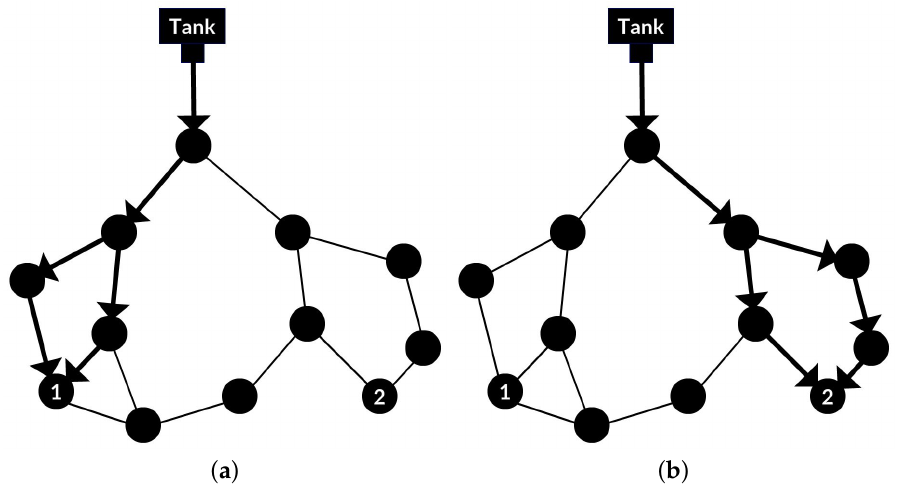
Figure 2. Unique leak signatures characterized by lean graphs of ( a ) J 1 , ( b ) J 2